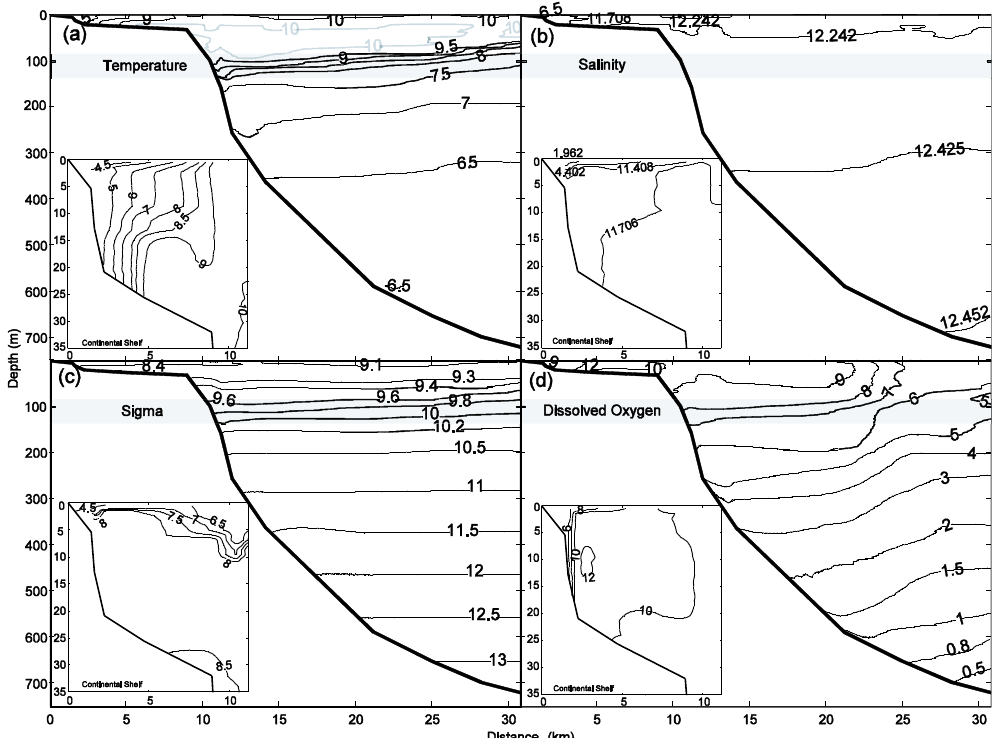
Fig. 2. Physical properties structures in cross-shore transect in the southwestern part of the CS; off AP in early winter 2008, the left side of the graphs is coast and right side is seaward (northward); vertical temperature structure (a) , vertical salinity structure (b) , vertical density distribution (c) , and dissolved oxygen concentrations (d) . The vertical structure of each physical property on the continental shelf area is presented in the inside